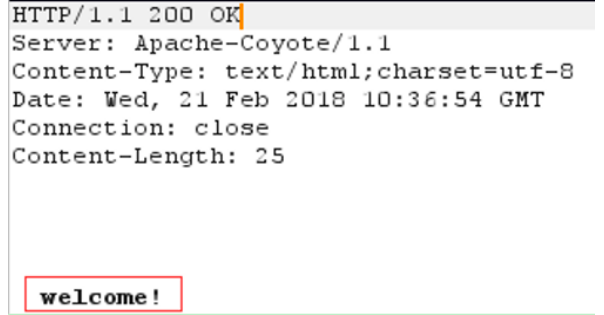
Figure 37. Response message for constructed request message.